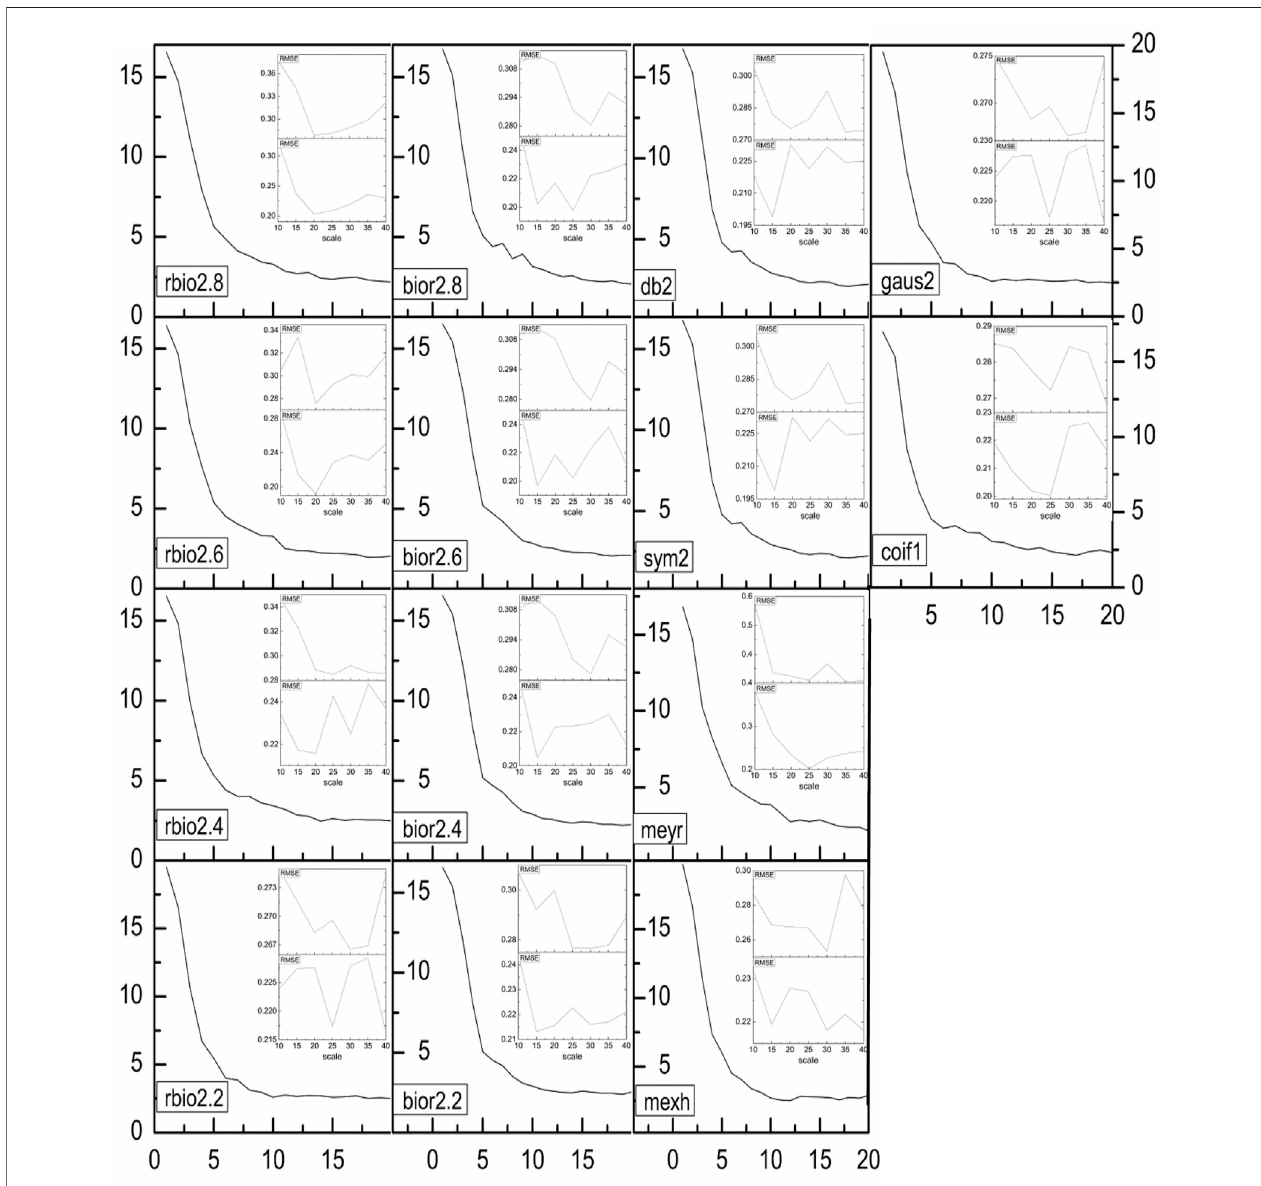
FIGURE6| TherelationshipbetweenFactorsandPRESSvaluesfortheregressionanalysisofthesignalsreconstructedbydifferentWT.TheupperistheRMSEfor prediction, and the lower is the RMSE for